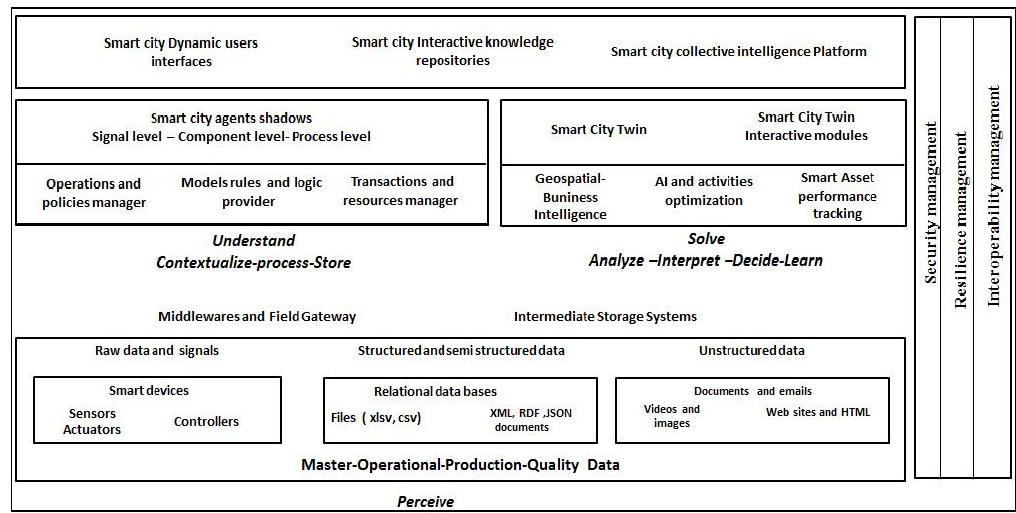
Figure 1. Smart city surrogate architecture